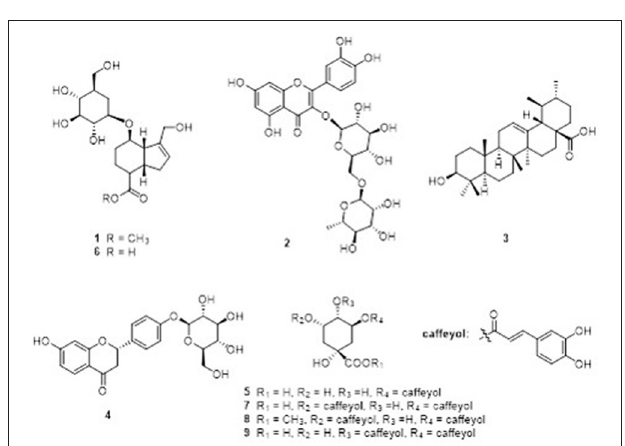
FIGURE 8 | Major compounds 1–9 identified in GJE-EA fraction. The GJE-EA fraction was chromatographed on silica gel column; the fractions were fractionated on Sephadex LH-20; and the compounds were purified by preparative HPLC. (1) geniposide; (2) rutin; (3) ursolic acid; (4) liquiritoside; (5) CGA; (6) GA; (7) 3,5-O-dicaffeoylquinic acid; (8) 3,5-O-dicaffeoylquinic acid methyl ester; and (9) 3,4-O-dicaffeoylquinic acid.